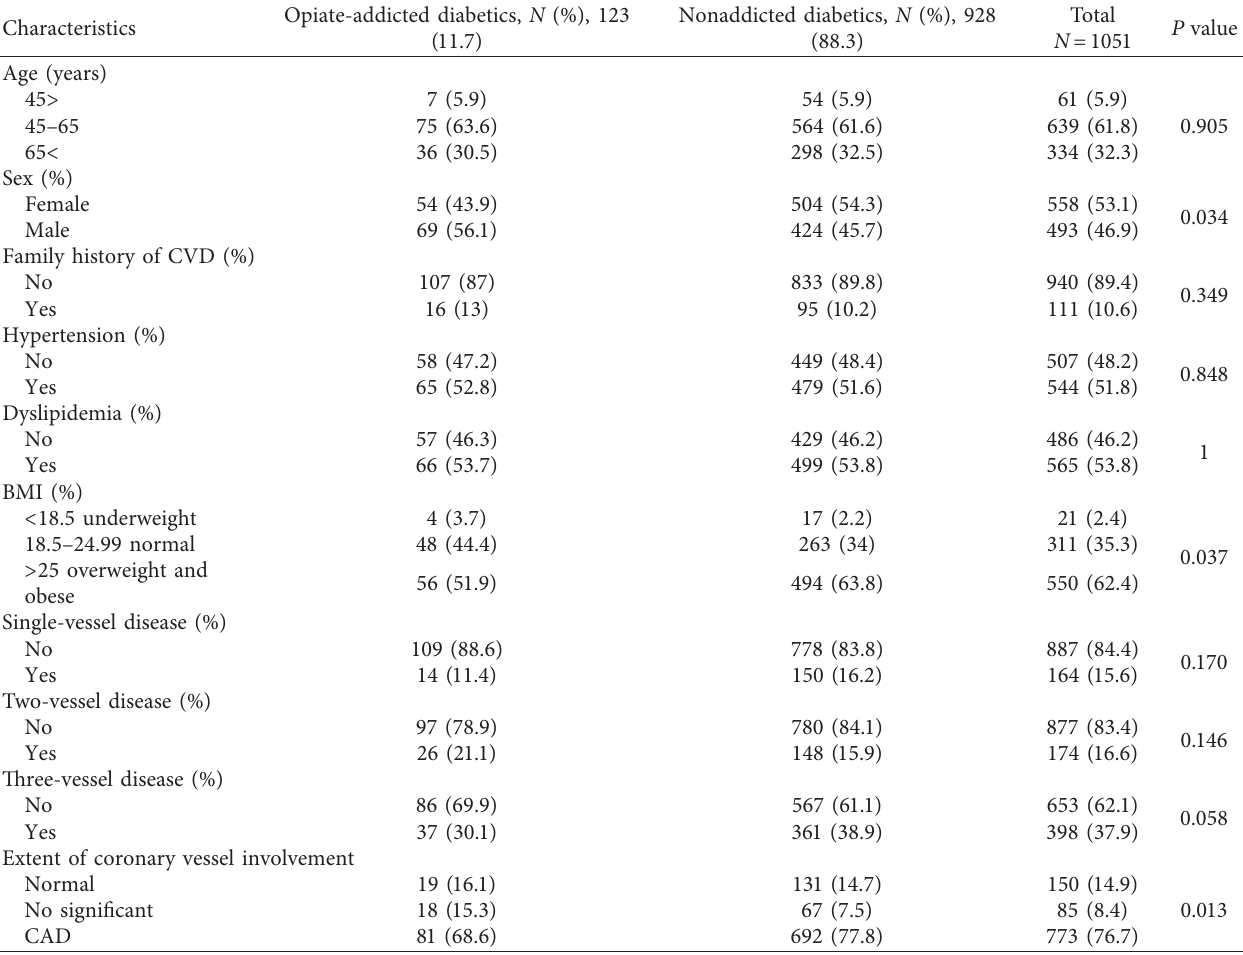
Table 1: Demographics and clinical characteristics of the participants.